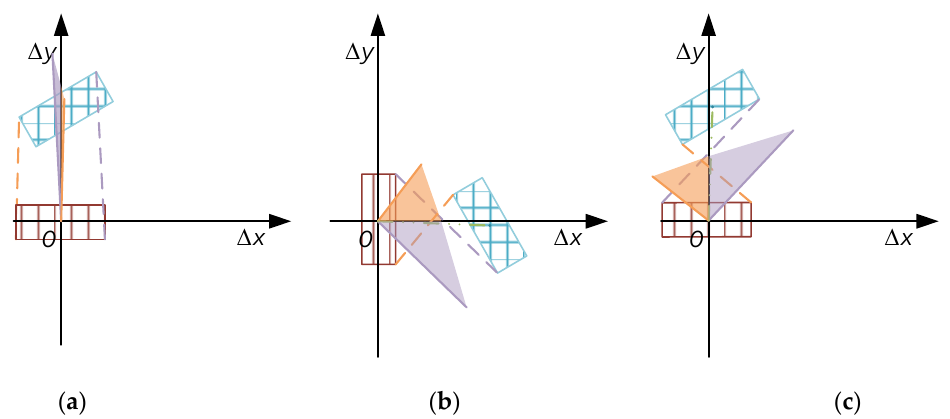
Figure 4. Selecting the critical collision point by slope (scenario 2). ( a ) The algorithm 1 was directly used in this scenario and obtained the wrong velocity obstacle cone. ( b ) After the vertices of the two ships rotated 90 ◦ clockwise around the origin, the velocity obstacle cone was obtained through algorithm 1. ( c ) shows ( b ) rotated 90 ◦ counterclockwise.